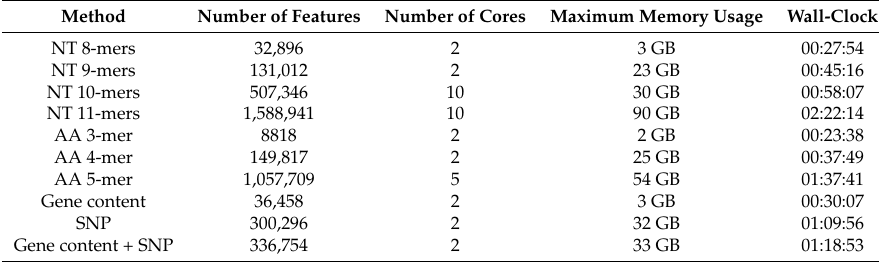
Table A68. Resources for N. gonhoriae –penicillin.